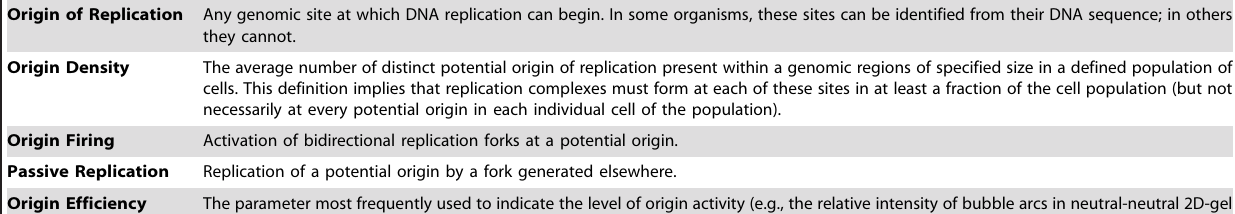
Origin of Replication Any genomic site at which DNA replication can begin. In some organisms, these sites can be identified from their DNA sequence; in others they